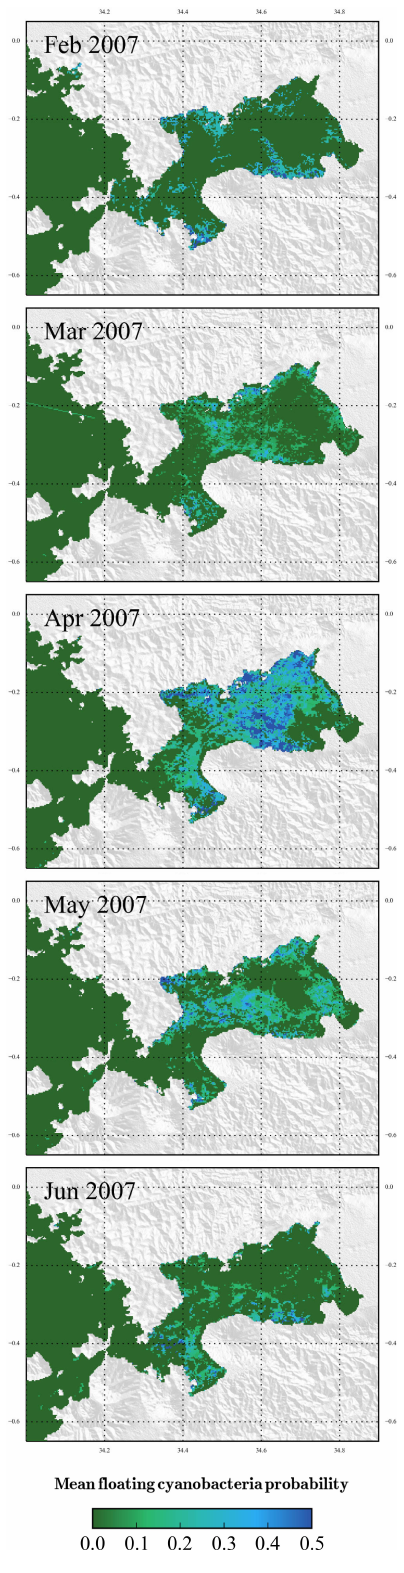
Figure 18. Peak of the 2007 water hyacinth growth in the Nyanza Gulf, Lake Victoria ( floating_cyanobacteria_mean